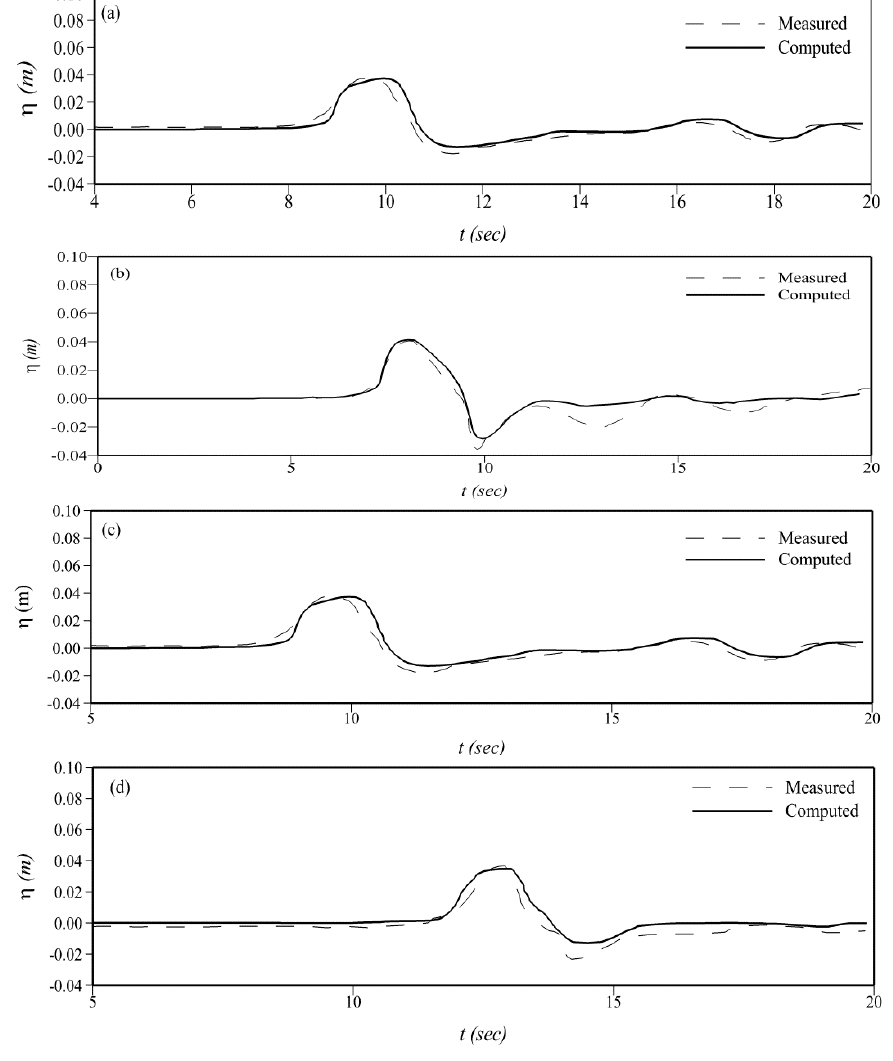
Figure 3. Comparison of the time history for free surface elevation at ( a ) gauge 6; ( b ) gauge 9; ( c ) gauge 16; and ( d ) gauge 22.